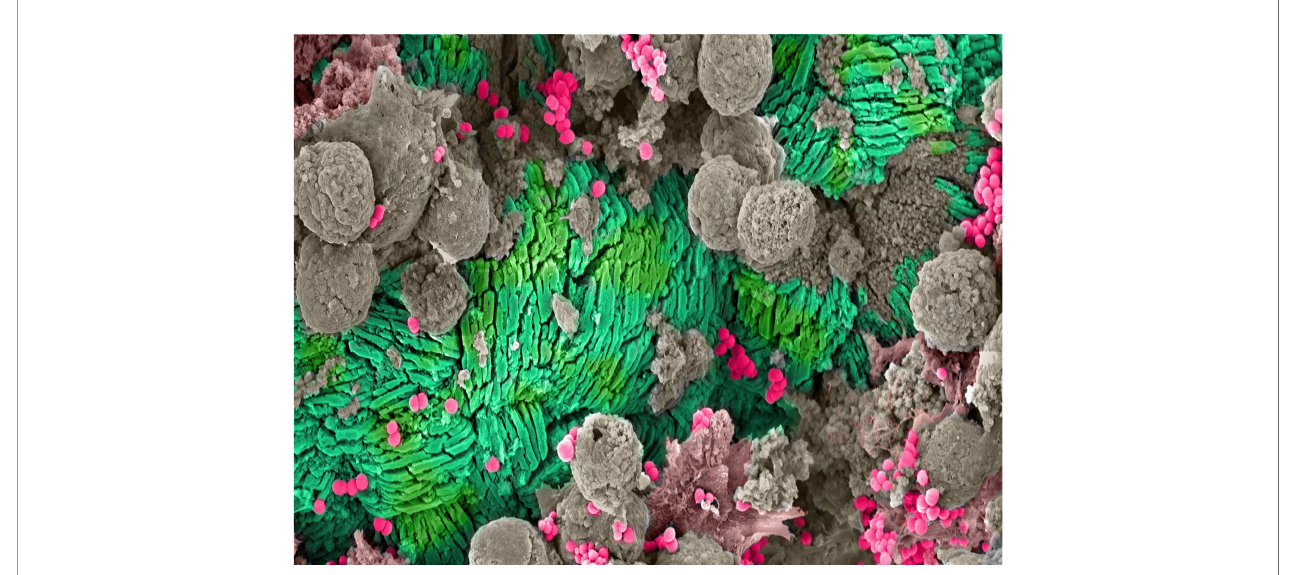
FIGURE 1 | Catheter Encrustation. Scanning electron microscope (SEM) image of crystalline precipitates forming a catheter encrustation (green) resulting from asymptomatic catheter-associated bacteriuria caused by Staphylococcus aureus (pink). The encrustation and bacteria are surrounded by host immune cells